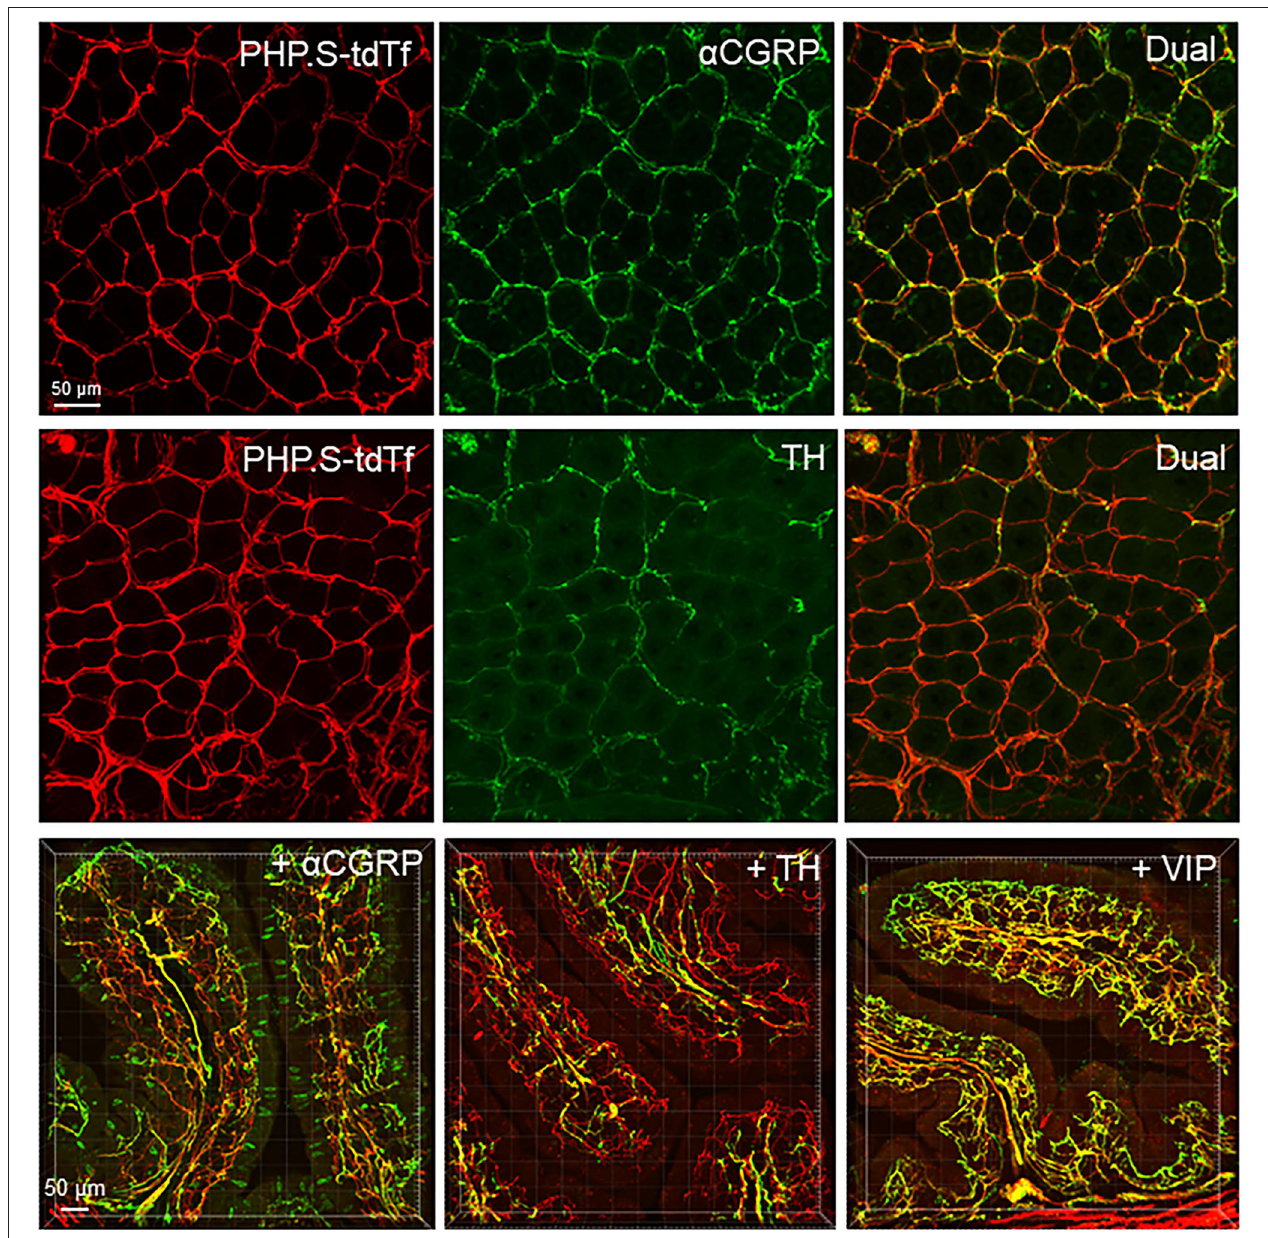
FIGURE 12 | PHP.S-tdTf (red) transduction in the mouse proximal colon mucosa combined with immunofluorescence (green) of calcitonin gene related peptide-alpha ( α CGRP), tyrosine hydroxylase (TH), and vasoactive intestinal peptide (VIP). PHP.S-tdTf was injected retro-orbitally at 1 x 10 12 GC/mouse 3 weeks before. Confocal microscopic images in the upper and middle rows were acquired from a flattened proximal colon wall at the level of the mucosal crypts, and images in the lower row were in trans-vertical sections. TH, α CGRP, and VIP immunofluorescence were found in PHP.S-tdTf transduced nerve fibers (yellow). Scale: 50 µ m same for upper and middle rows and 50 µ m same for the lower